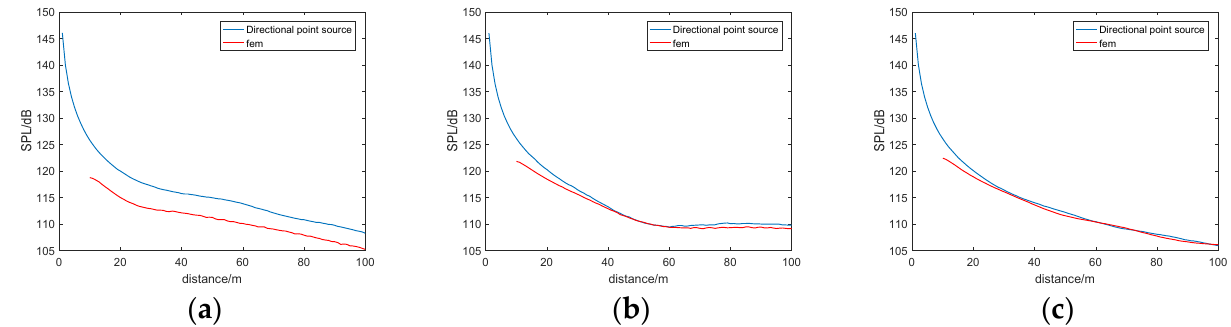
Figure 5. Schematic of equivalent theory of directional point source. ( a ) The target 20 m away from the interface ( b ) The target 30 m away from the interface ( c ) The target 180 m away from the interface.